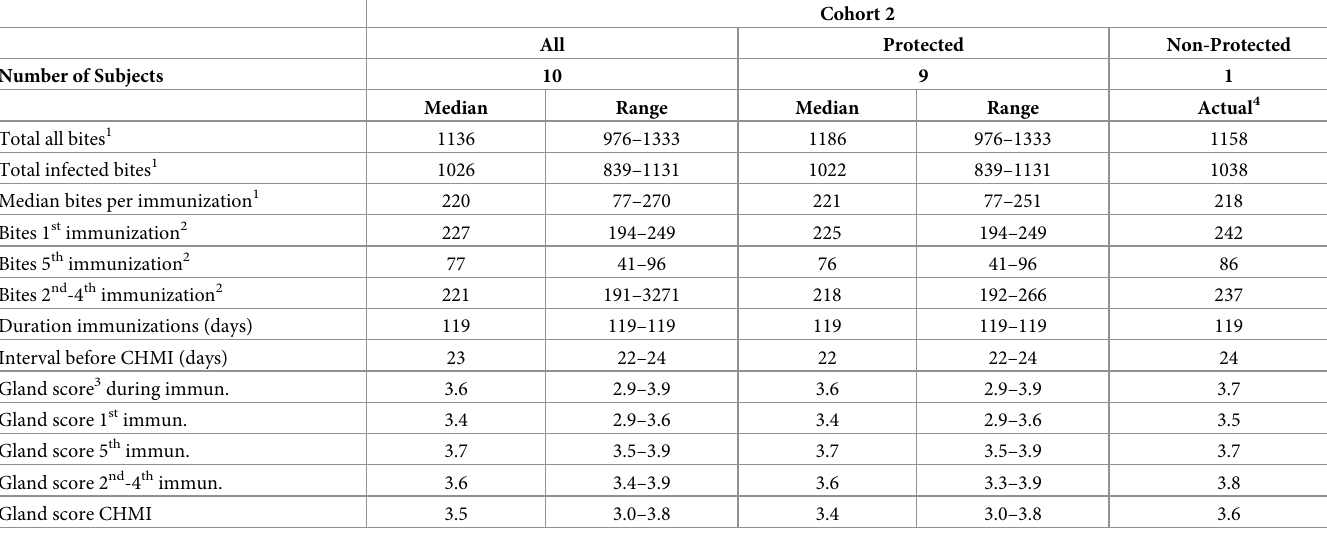
Table 5. Cohort 2—Summary of true-immunizations: mosquito bites, gland scores and duration of